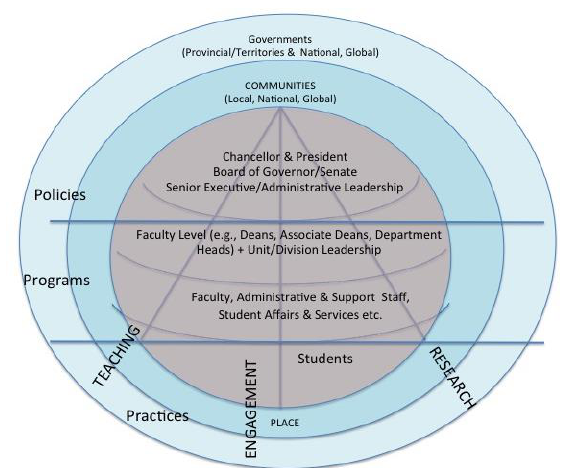
Figure 2. Visual representation of inter-connections of higher